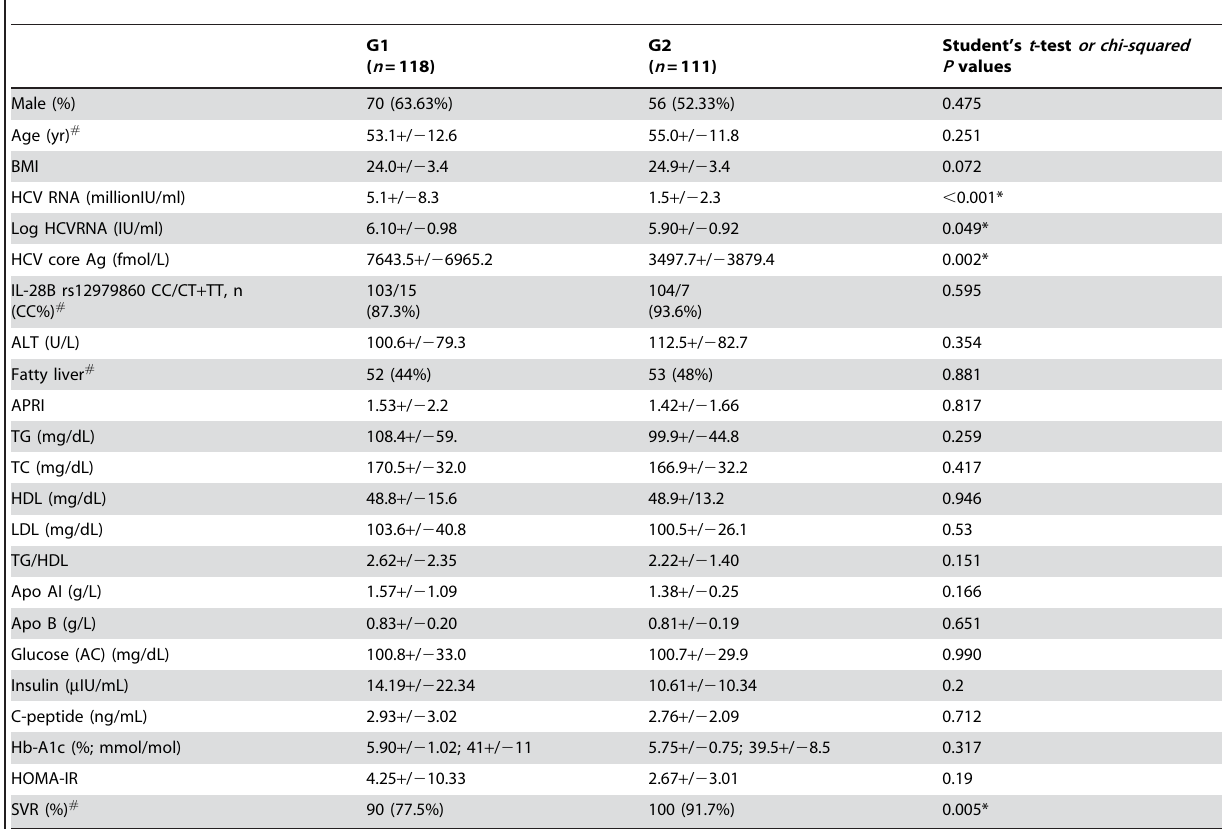
Table 1. Baseline characteristics of the CHC patients before anti-HCV